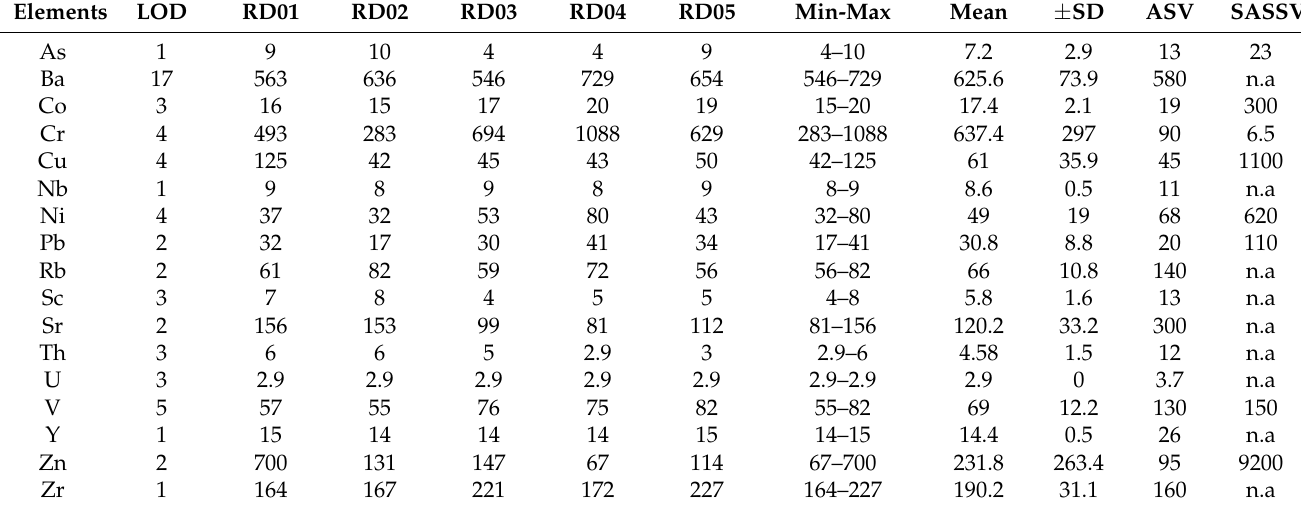
Table 4. Statistical analysis of trace elements concentration (mg/kg) in road dust samples with average shale values (mg/kg) and South African soil screening values